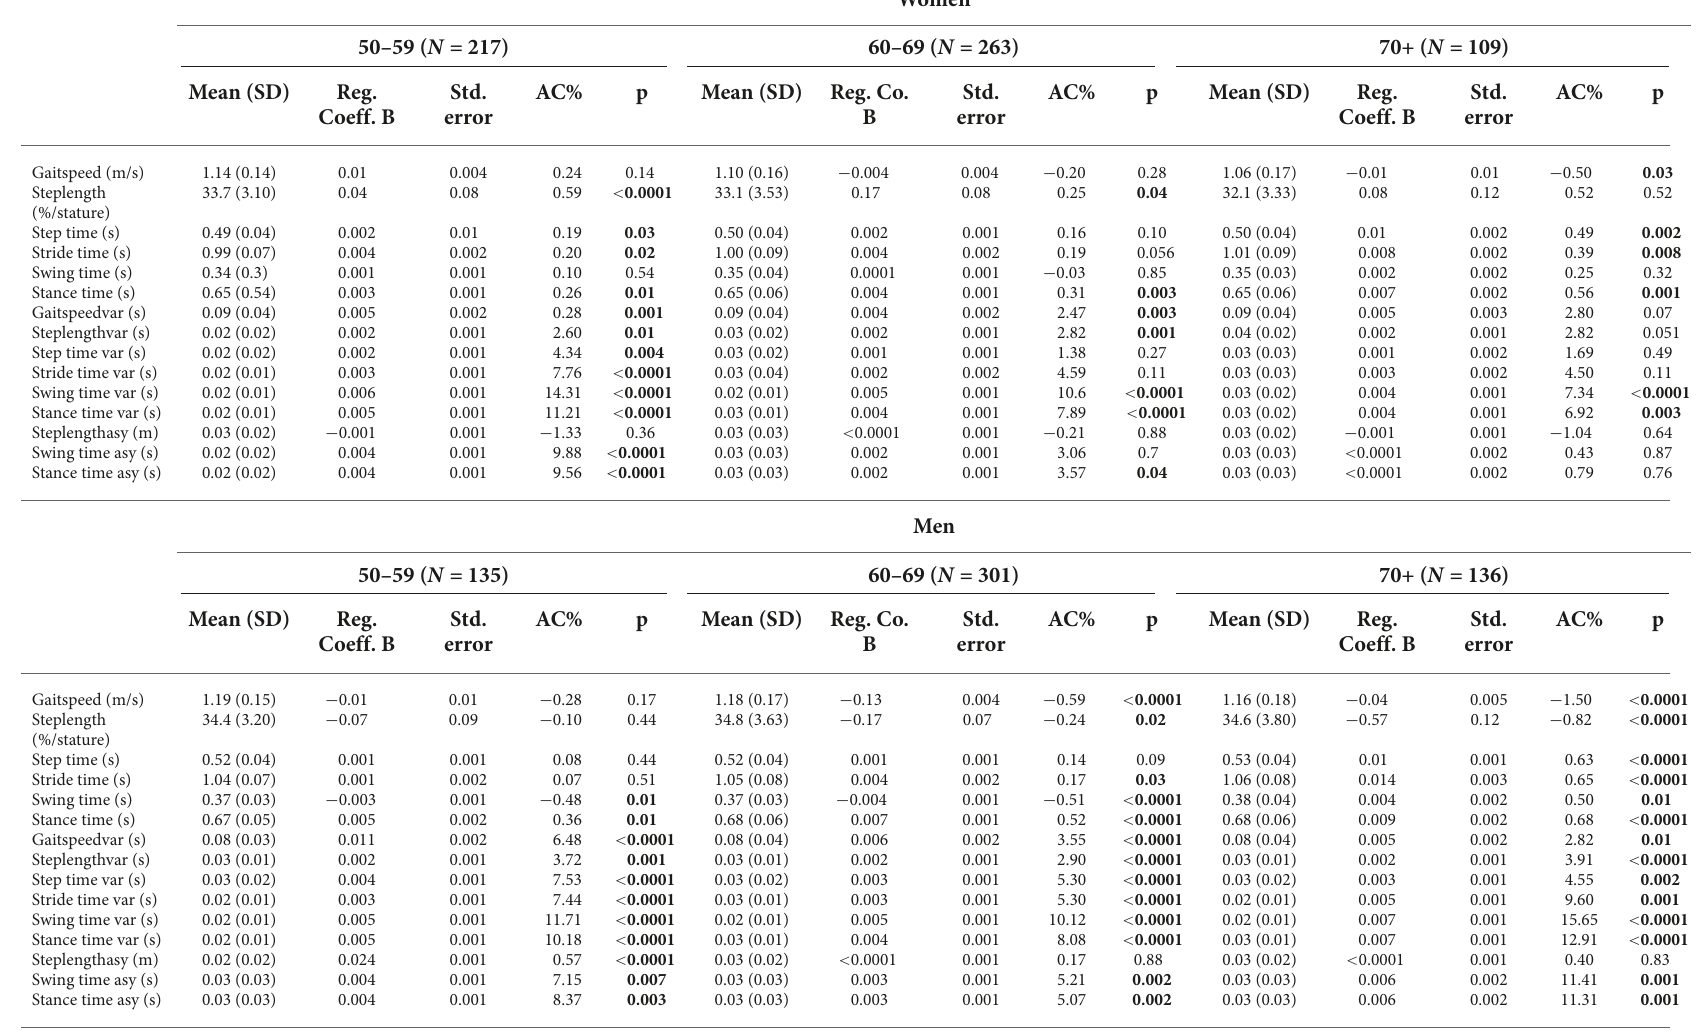
TABLE 4 Mean performance and annual change over 6 years observation period of women and men separated by age